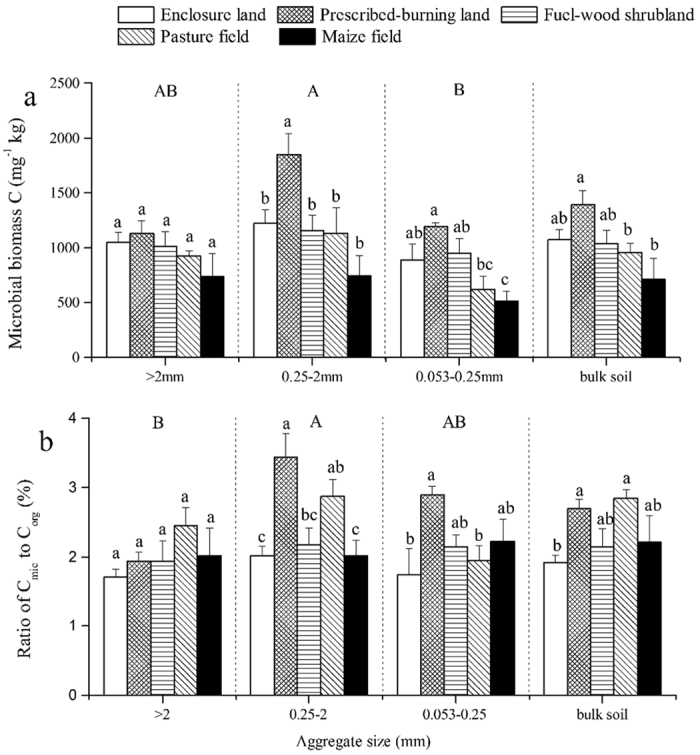
Microbial biomass carbon (MBC) (a) and the Cmic: Corg ratios (b) of the three sizes of soil aggregates and bulk soil of different land uses. Values are means of three replicates (± standard error). Different lowercase letters indicate significant differences among land uses for each size of soil aggregate and for bulk soil. Different uppercase letters indicate significant differences among the three sizes of soil aggregates.